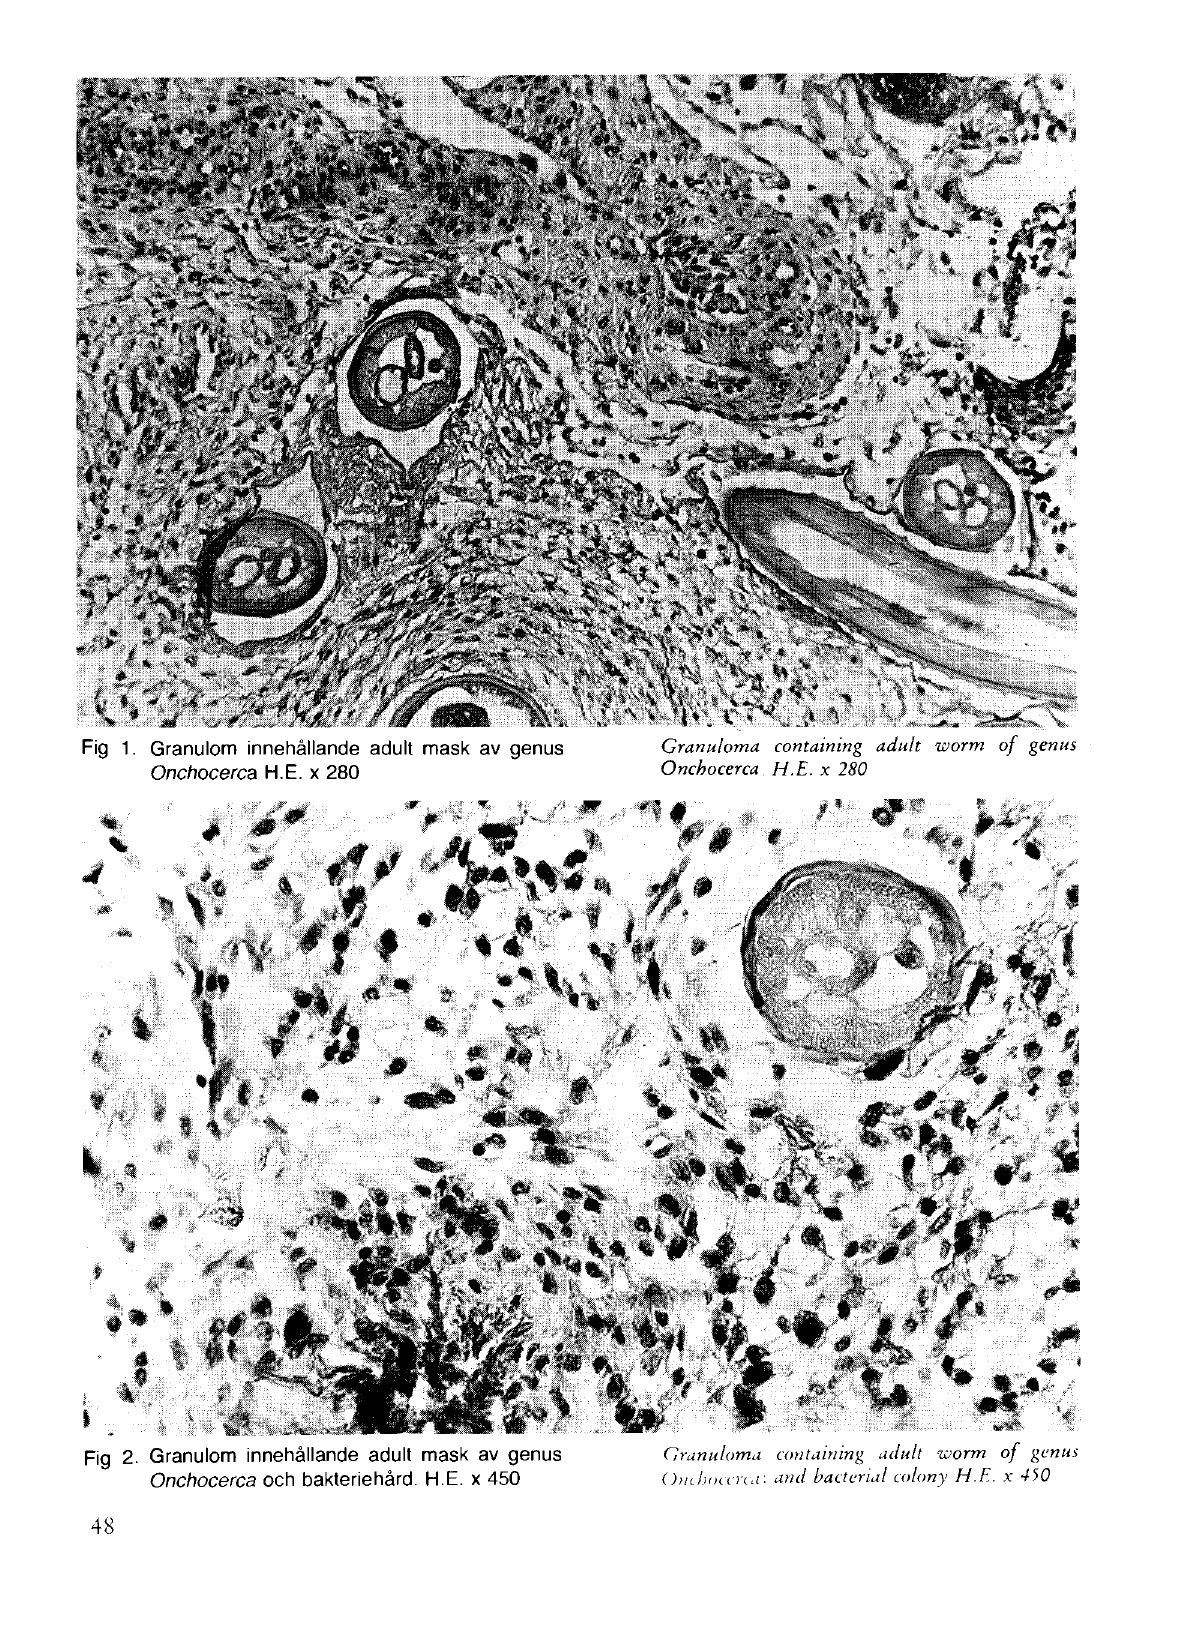
Fig 2. Granulom innehållande adult mask av genus Onchocerca och bakteriehård. H.E. x 450